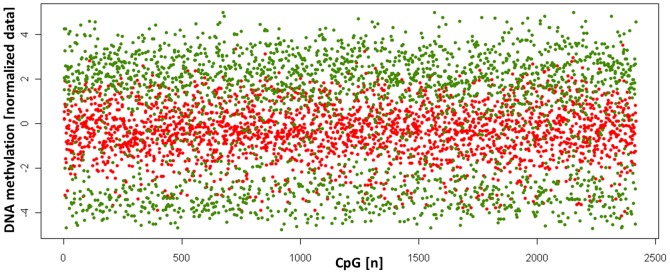
CpG loci differentially methylated between AC and CVS samples preferentially show an intermediate methylation level in CVS.Scatter plot of the means of DNA methylation values of all 2418 CpG loci differentially methylated between samples obtained by amniocentesis (AC, green circle) and chorionic villi biopsy (CVS, red circle) samples (FDR<1×10−15). For all loci the means have been calculated in AC and CVS separately and subsequently plotted. Most CpG loci are characterized by either a high or a low DNA methylation value in AC but an intermediate DNA methylation value in CVS.